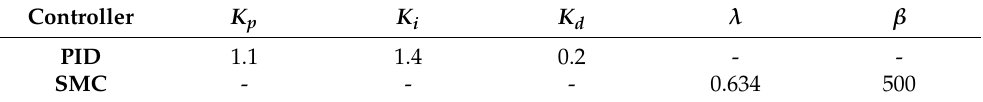
Table 2. Tuning parameters of the